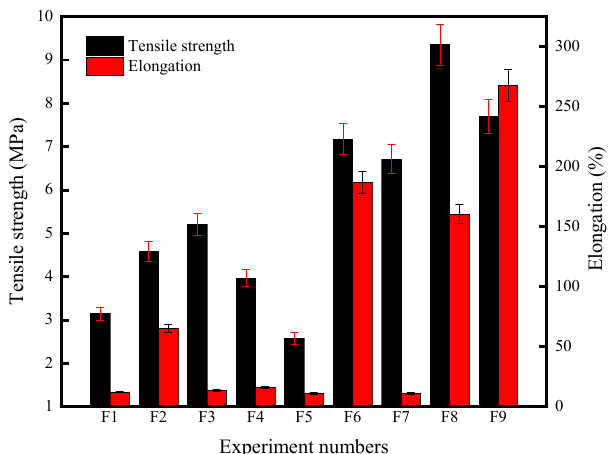
Figure 5. Tensile strength and elongation of pure and functional PU films loaded with different fillers.